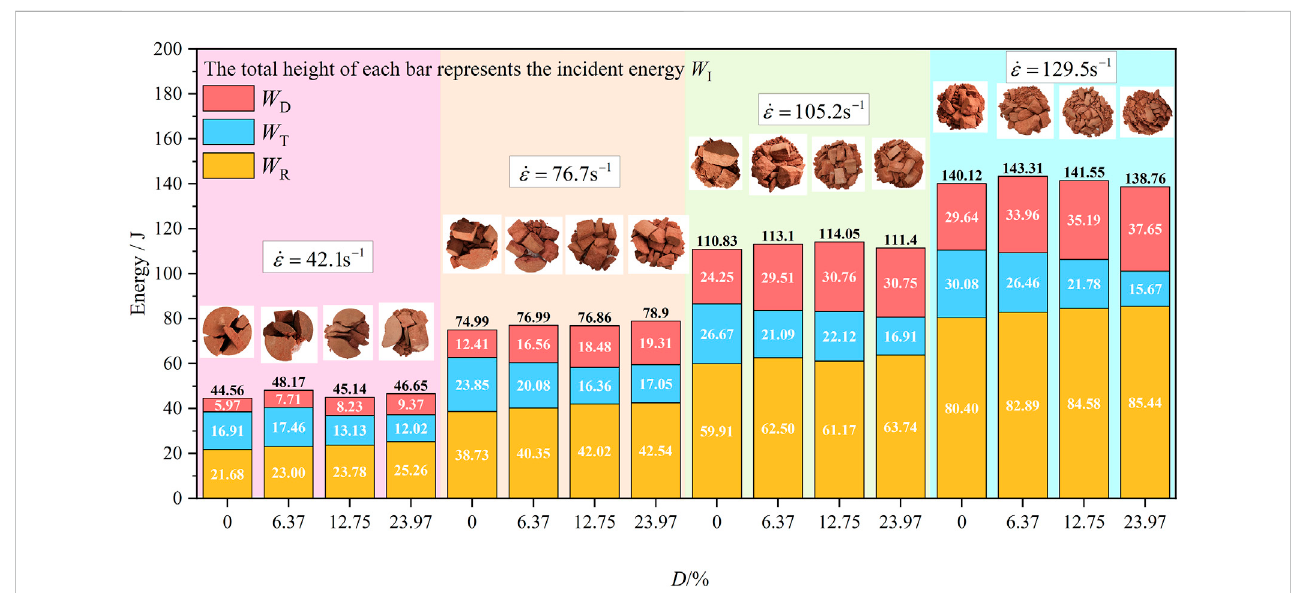
FIGURE 7 Energy variation and failure morphology of frozen sandstone with different initial damage values and strain